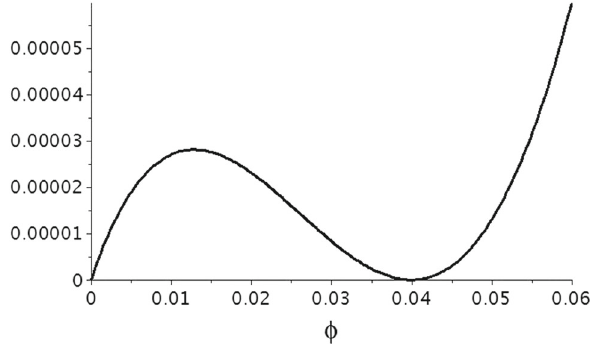
Fig. 5 The potential density in the Einstein frame. The Lagrangian parameters are d 0 = d 1 + 1 = 4 , d 2 = 2 ; a = − 2 ; b = 1 ; c = − 0 . 02 ; c = 37 , c = − 32 1 2 ≡ φ = const and hence the size of extra Ricci scalar R d c 2 is also space M d 2